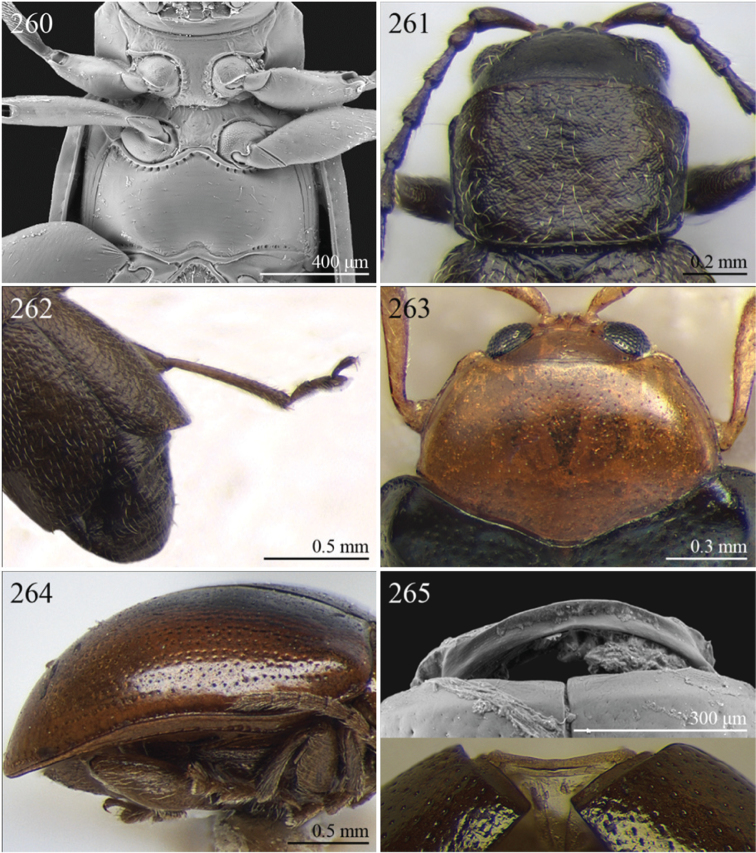
Morphological characters. 260
Seychellaltica mahensis (Maulik), pro-, meso- and metasternum 261
Sjostedtinia fordi Bryant, head and pronotum in dorsal view 262 Ditto, hind leg and elytra in dorsal view 263
Sphaeroderma nigripennis Bryant, head and pronotum in dorsal view 264 Sphaeroderma iyengari Bechyné, elytra in lateral view 265
Stegnaspea trimeni Baly, basal part of elytra.